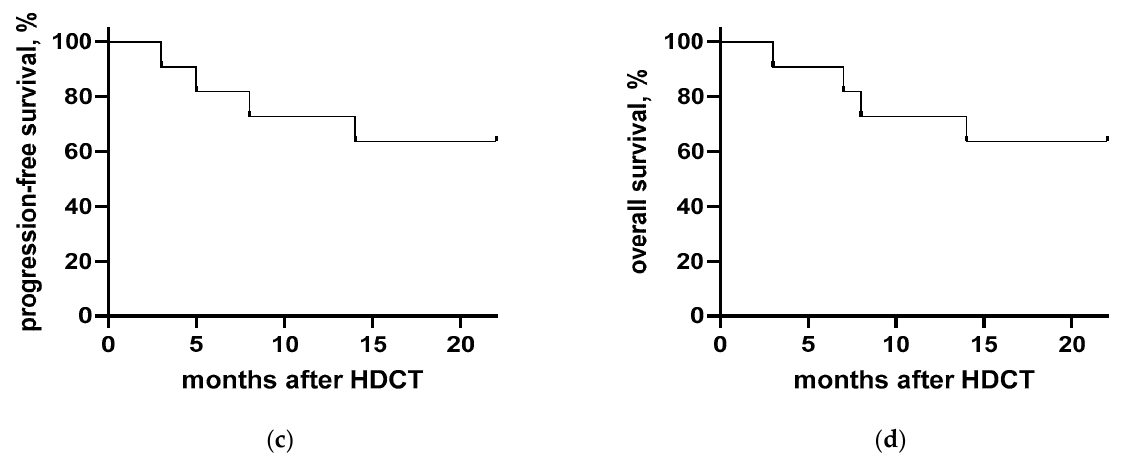
Figure 1. ( a ) Progression-free and ( b ) overall survival at a 100-day follow-up after HDCT/ASCT in patients who received Bortezomib-BeEAM. ( c ) Progression-free and ( d ) overall survival at the last assessed follow-up at a median of 22 months after HDCT/ASCT in patients who received borte- zomib.